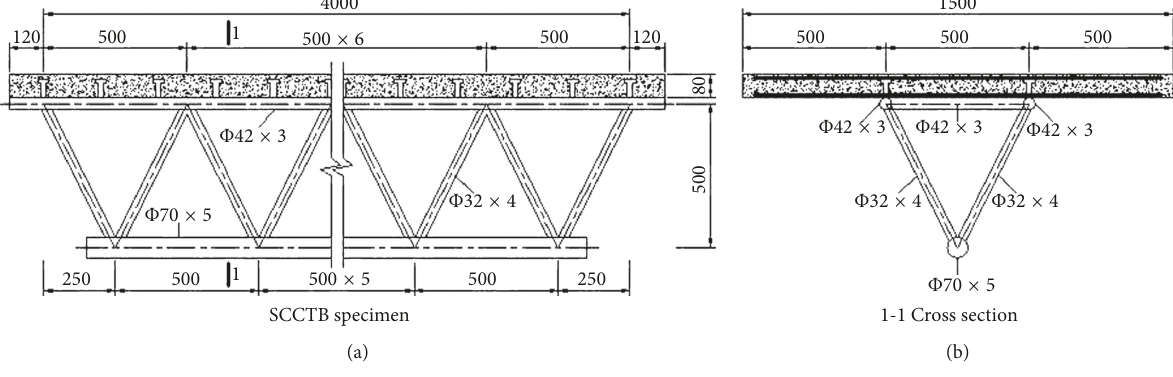
Figure 1: Dimensions of the SCCTB specimens.